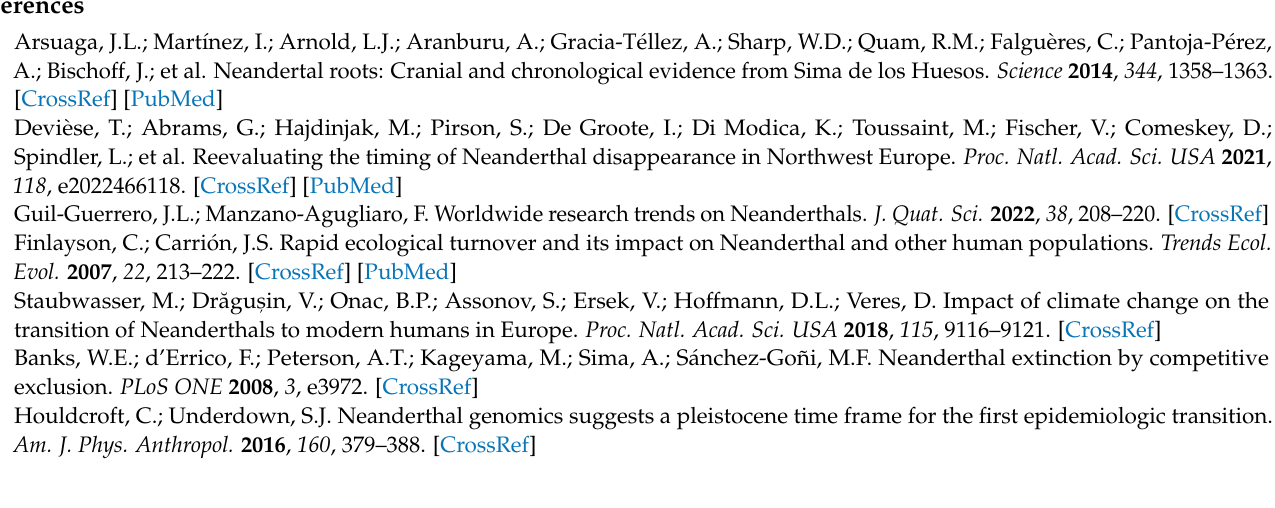
Table S3. Organ weights, kcal, and ascorbic acid content of a medium-sized reed deer (325 kg); File S4: Supporting Table S4. Organ weights, kcal, and ascorbic acid content of a medium-sized bison (910 kg); File S5: Supporting Table S5. Organ weights, kcal, and ascorbic acid content of a medium-sized woolly rhinoceros (2000 kg); File S6: Supporting Table S6. Organ weights, kcal, and ascorbic acid content of a medium-sized woolly mammoth (4000 kg); File S7: Supporting Table S7. Daily needs of energy, meat, and fatty tissues for a 2.5 g protein/kg · day muskox-fed 22-individualss M3H group. Funding: The authors acknowledge the financial support of Junta de Andaluc í a (Proyect